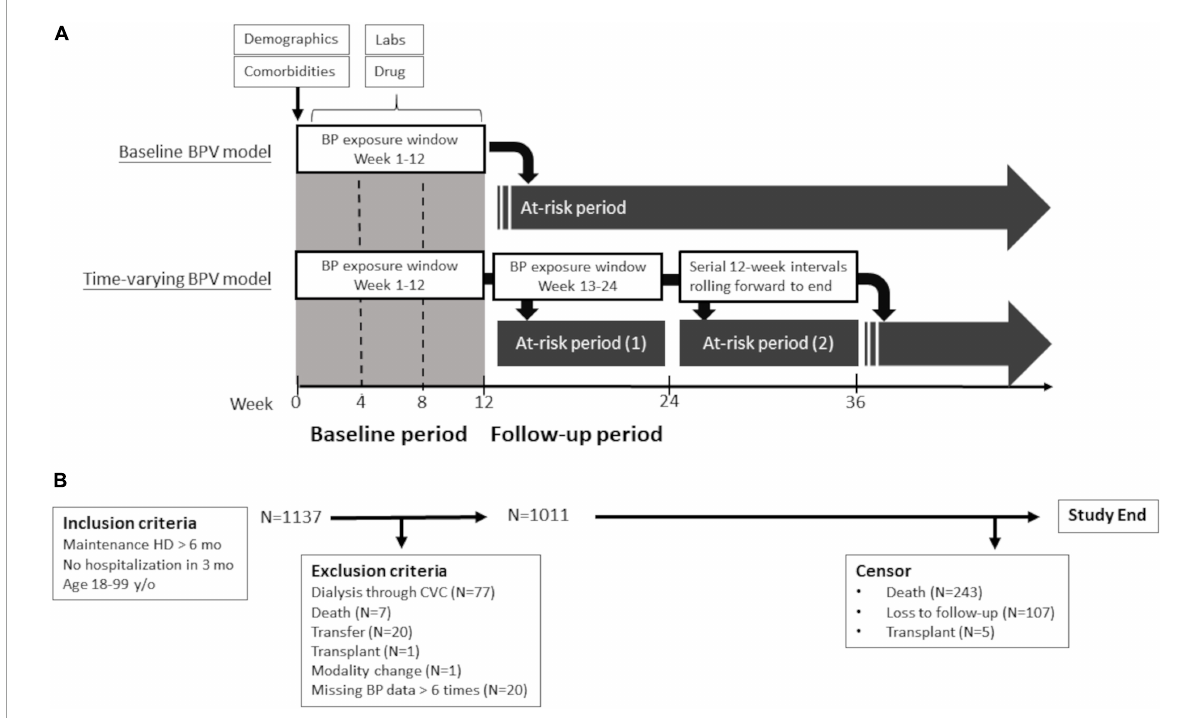
FIGURE1 Study design (A) and flow diagram (B) . Flow diagram of study participants and schematic presentation of outcomes models for primary analysis (baseline BPV model) and comparative analysis (time-varying BPV model). BP, blood pressure; BPV, blood pressure variability; CVC, central vein catheter; HD, hemodialysis; and lab, laboratory